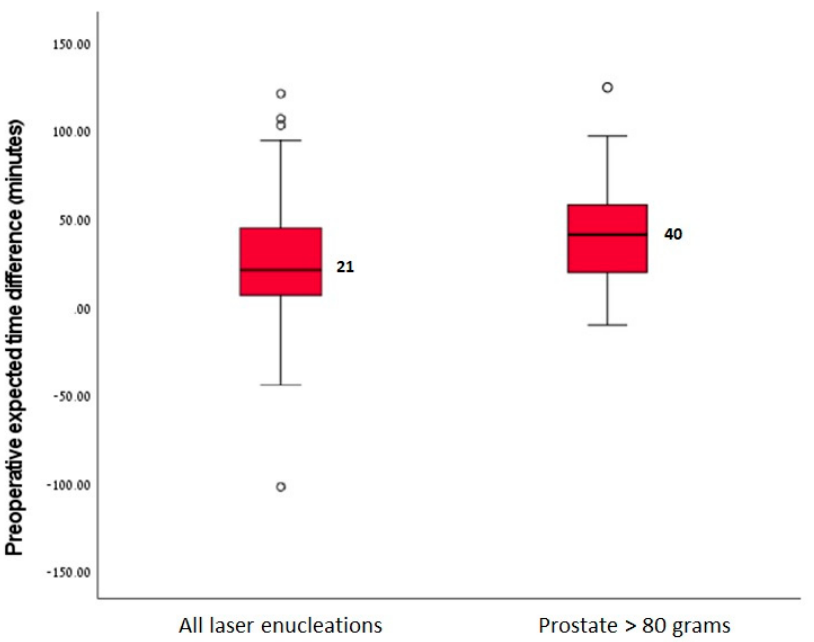
Figure 2. Box-and-whisker plot showing the difference in the expected operative duration between sonographic and adjusted prostate volume sonographic and adjusted prostate volume estimations.